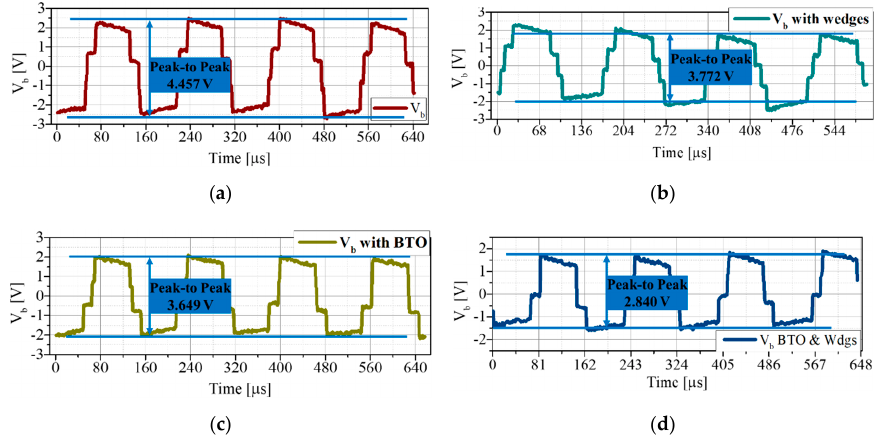
Figure 11. Shaft voltage (bearing voltage) of the motor. ( a ) Shaft voltage of the motor without a rotor BTO layer and without stator tooth wedges. ( b ) Shaft voltage of the motor without a rotor BTO layer and with stator tooth wedges. ( c ) Shaft voltage of the motor with the rotor BTO layer and without stator tooth wedges. ( d ) Shaft voltage of the motor with the rotor BTO layer and with stator tooth wedges.